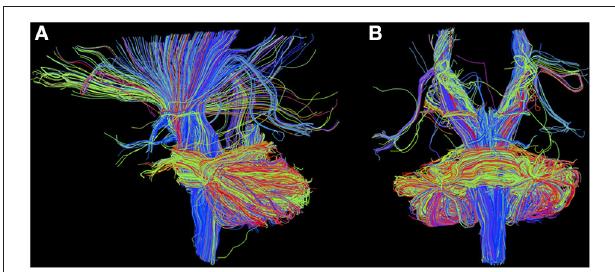
FIGURE 6 | Diffusion MRI with region-of-interest-based deterministic tractography using TrackVis in sagittal (A) and coronal (B) view, rendered as described with MR data from the protocol pilot run (3T MAGNETOM Prisma, Brain Imaging Center Frankfurt) obtained from a healthy 32-year-old male test